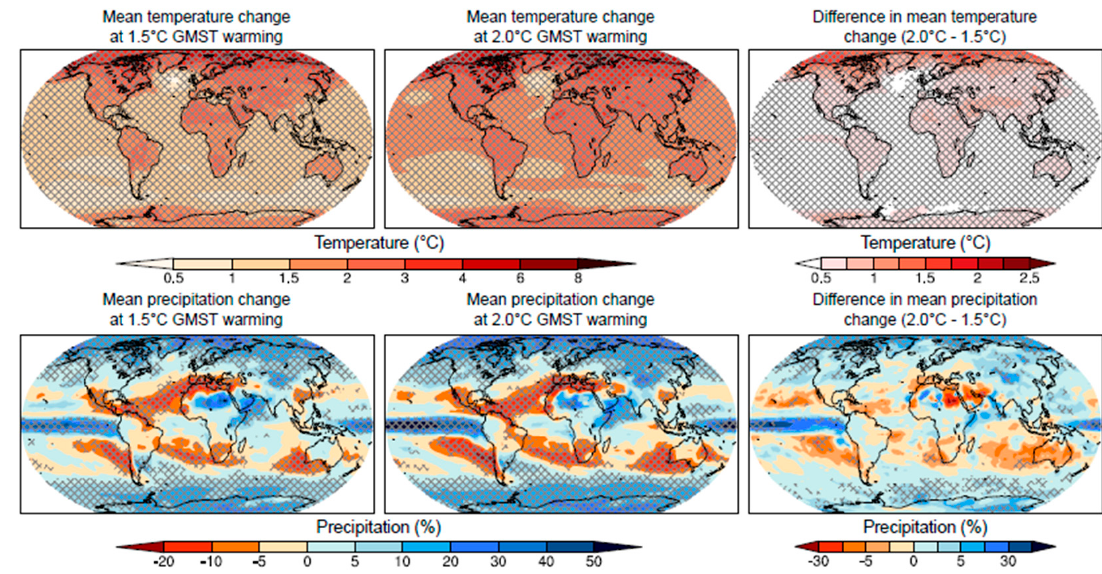
Figure 1. The figure, taken from the latest report “Global Warming of 1.5°” of the Intergovernmental Panel on Climate Change (2019) [4], unfortunately confirms the evolution of and increase in the effects produced by climate change, affecting our planet as a result of global warming, and a greater intensification of extreme events.